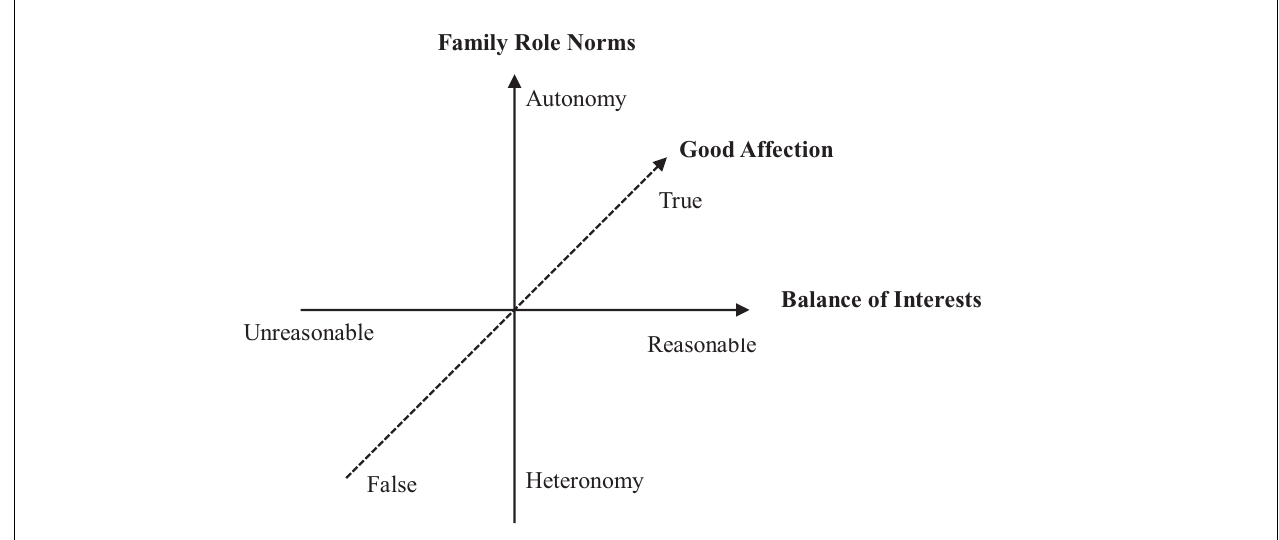
FIGURE 1 | The three-dimensional filial piety model. Adapted from Wang and Zheng (2015). Copyright 2018 by F. Y. Wang (Reprinted with